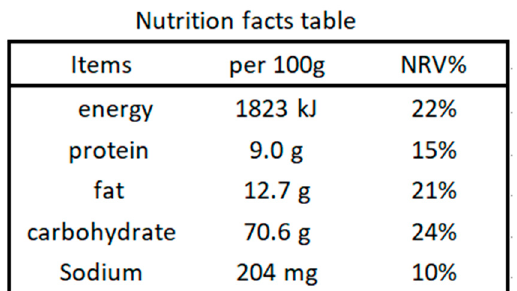
Figure 1. A sketch map of a nutrition facts table. Source: Chinese Nutrition Society [12].